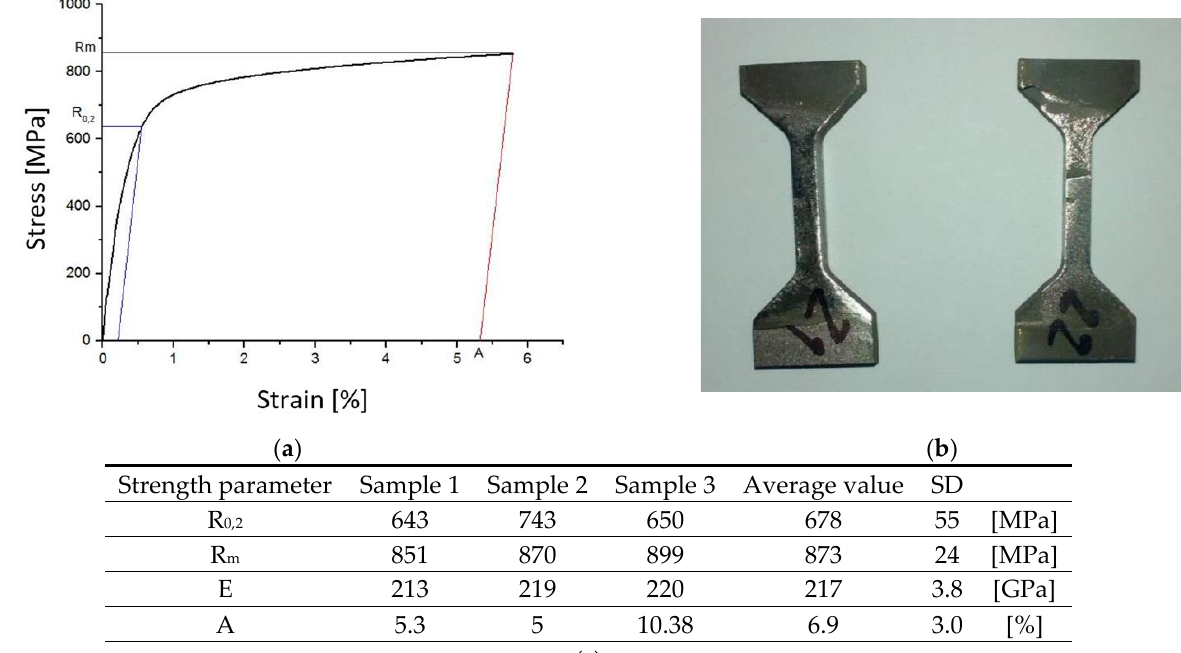
Figure 18. Tensile curve of the blade material ( a ), view of specimens before and after the tensile test ( b ), and the determined strength parameters ( c ).